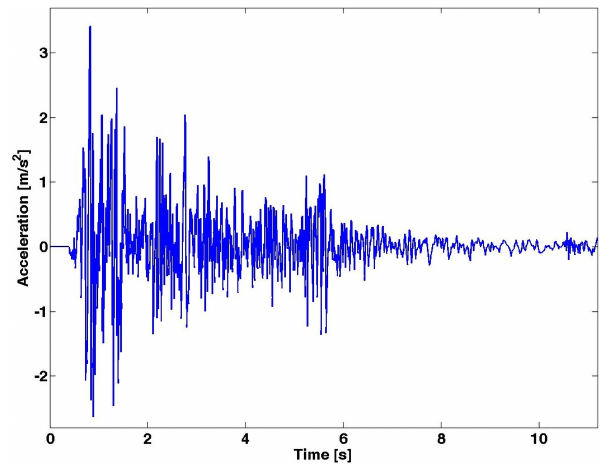
Figure 8. The NS (north–south) time-scaled component of the 1940 El Centro earthquake.